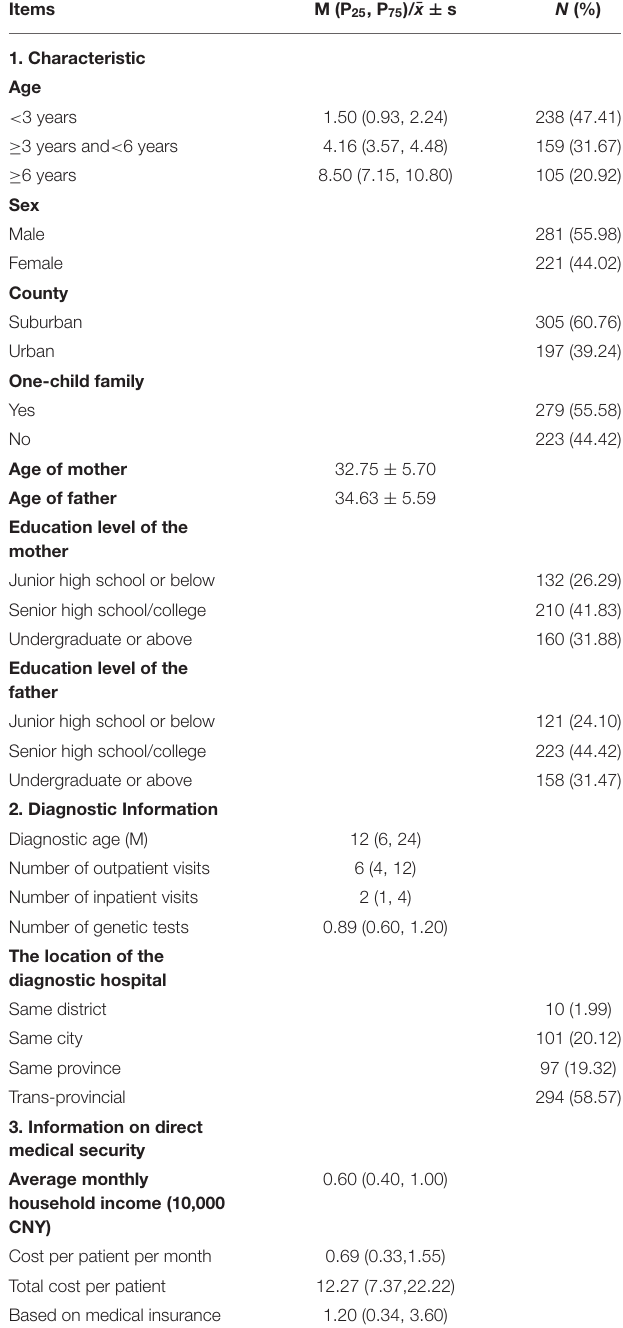
TABLE 1 | Characteristics of the population ( n = 502) and basic information on GD and medical insurance.